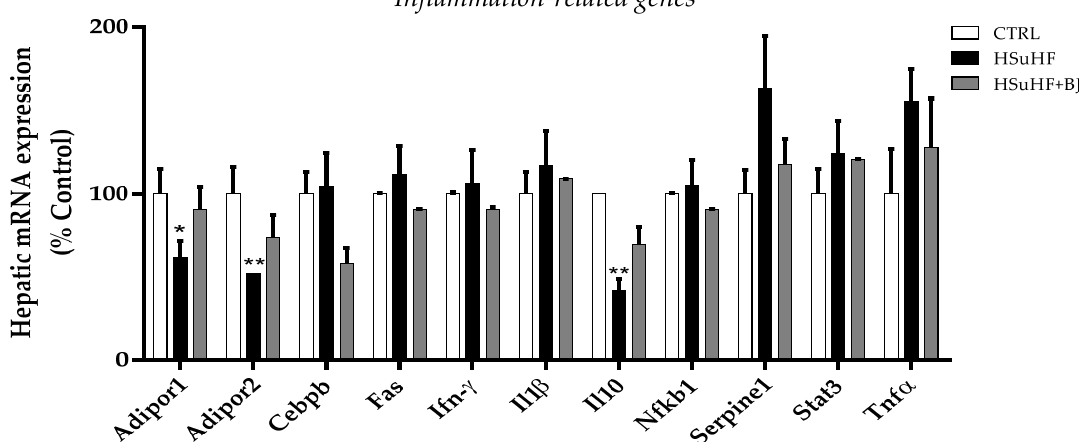
Figure 6. Hepatic mRNA expression of genes related to the inflammatory response of the CTRL, HSuHF, and HSuHF + BJ groups. Data are presented as the mean ± SEM. ( n = 6–8/group). * p < 0.05, ** p < 0.01 vs. CTRL group. CTRL: control. HSuHF: high sucrose/high-fat. BJ: blueberry juice.